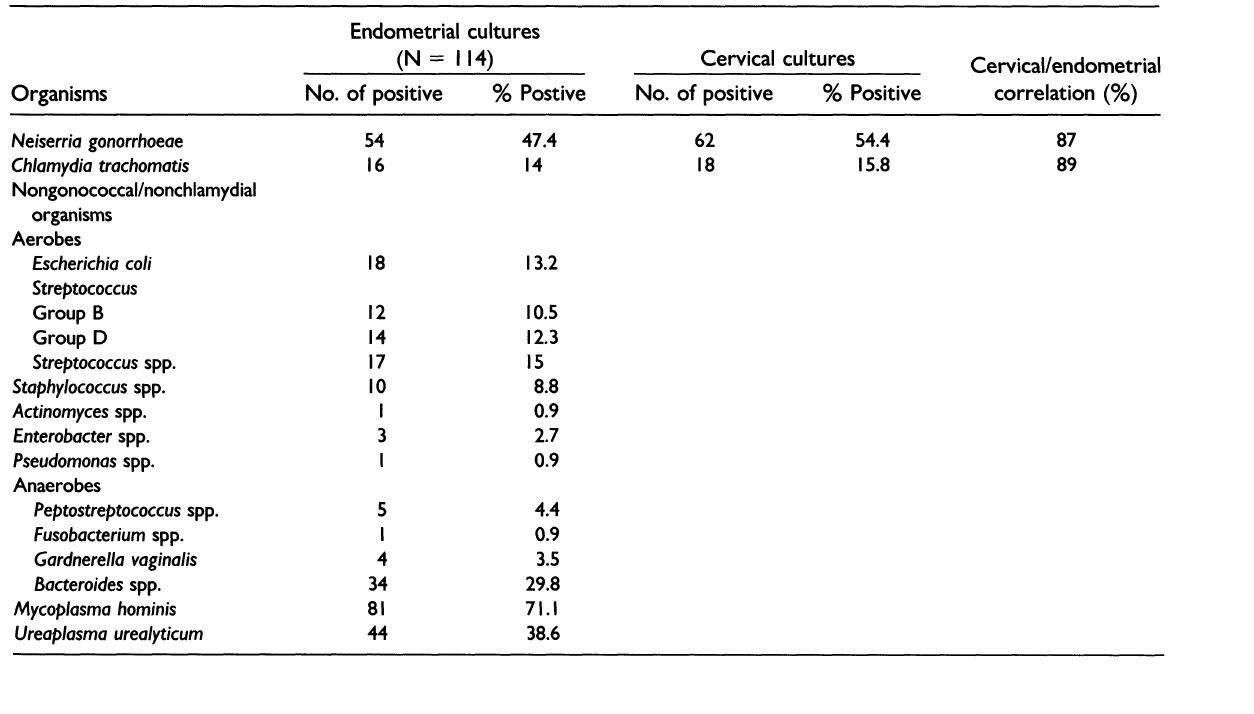
TABLE I. Results of endometrial